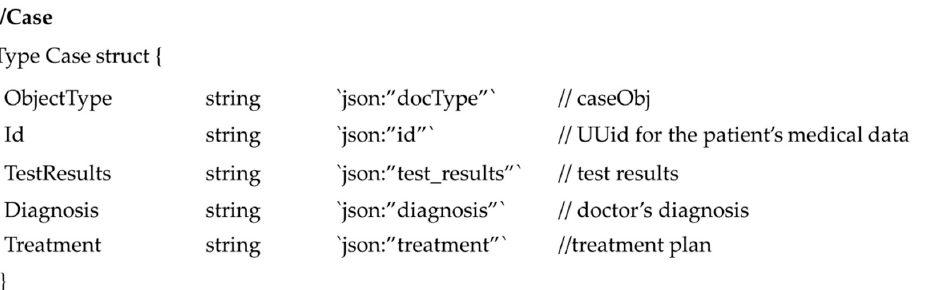
Figure 5. Data type of Case.